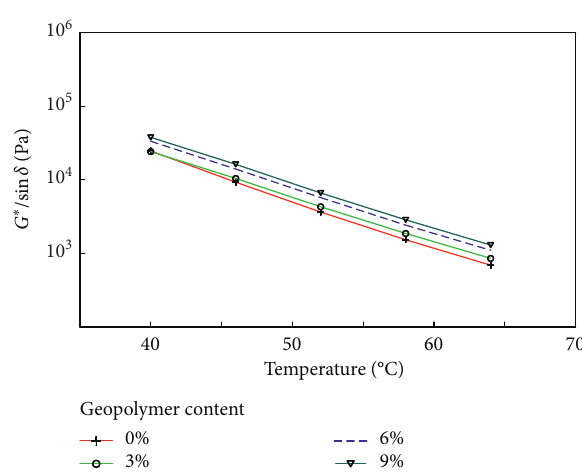
Figure 9: Temperature effect on rutting factor ( G ∗ /sin δ